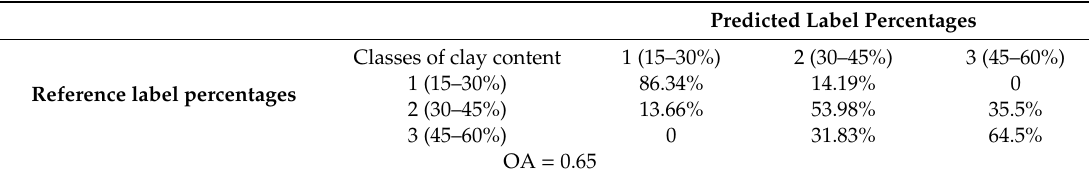
Table 7. Confusion matrix for the RF classification, using soil moisture products for clay content mapping.